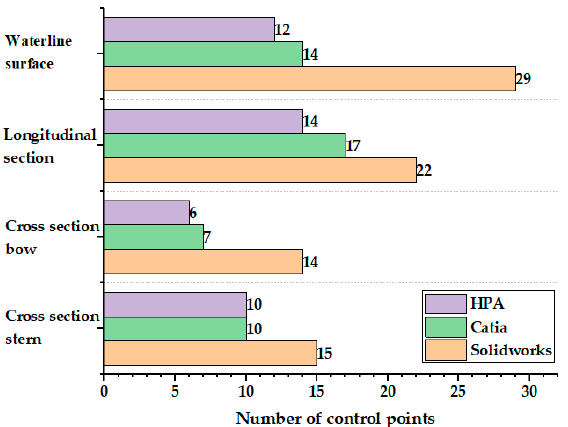
Figure 18. Number of control points when the maximum single point error is within 0.1 m.